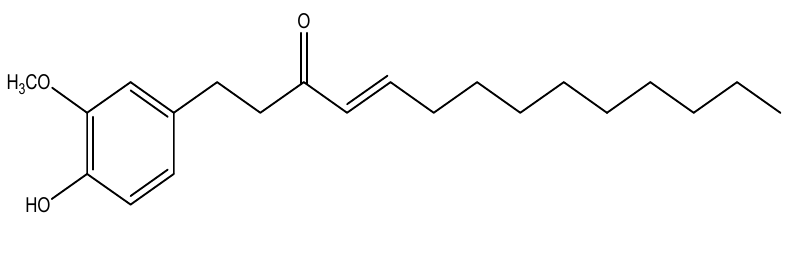
Figure 1. The structure of ginger compound,